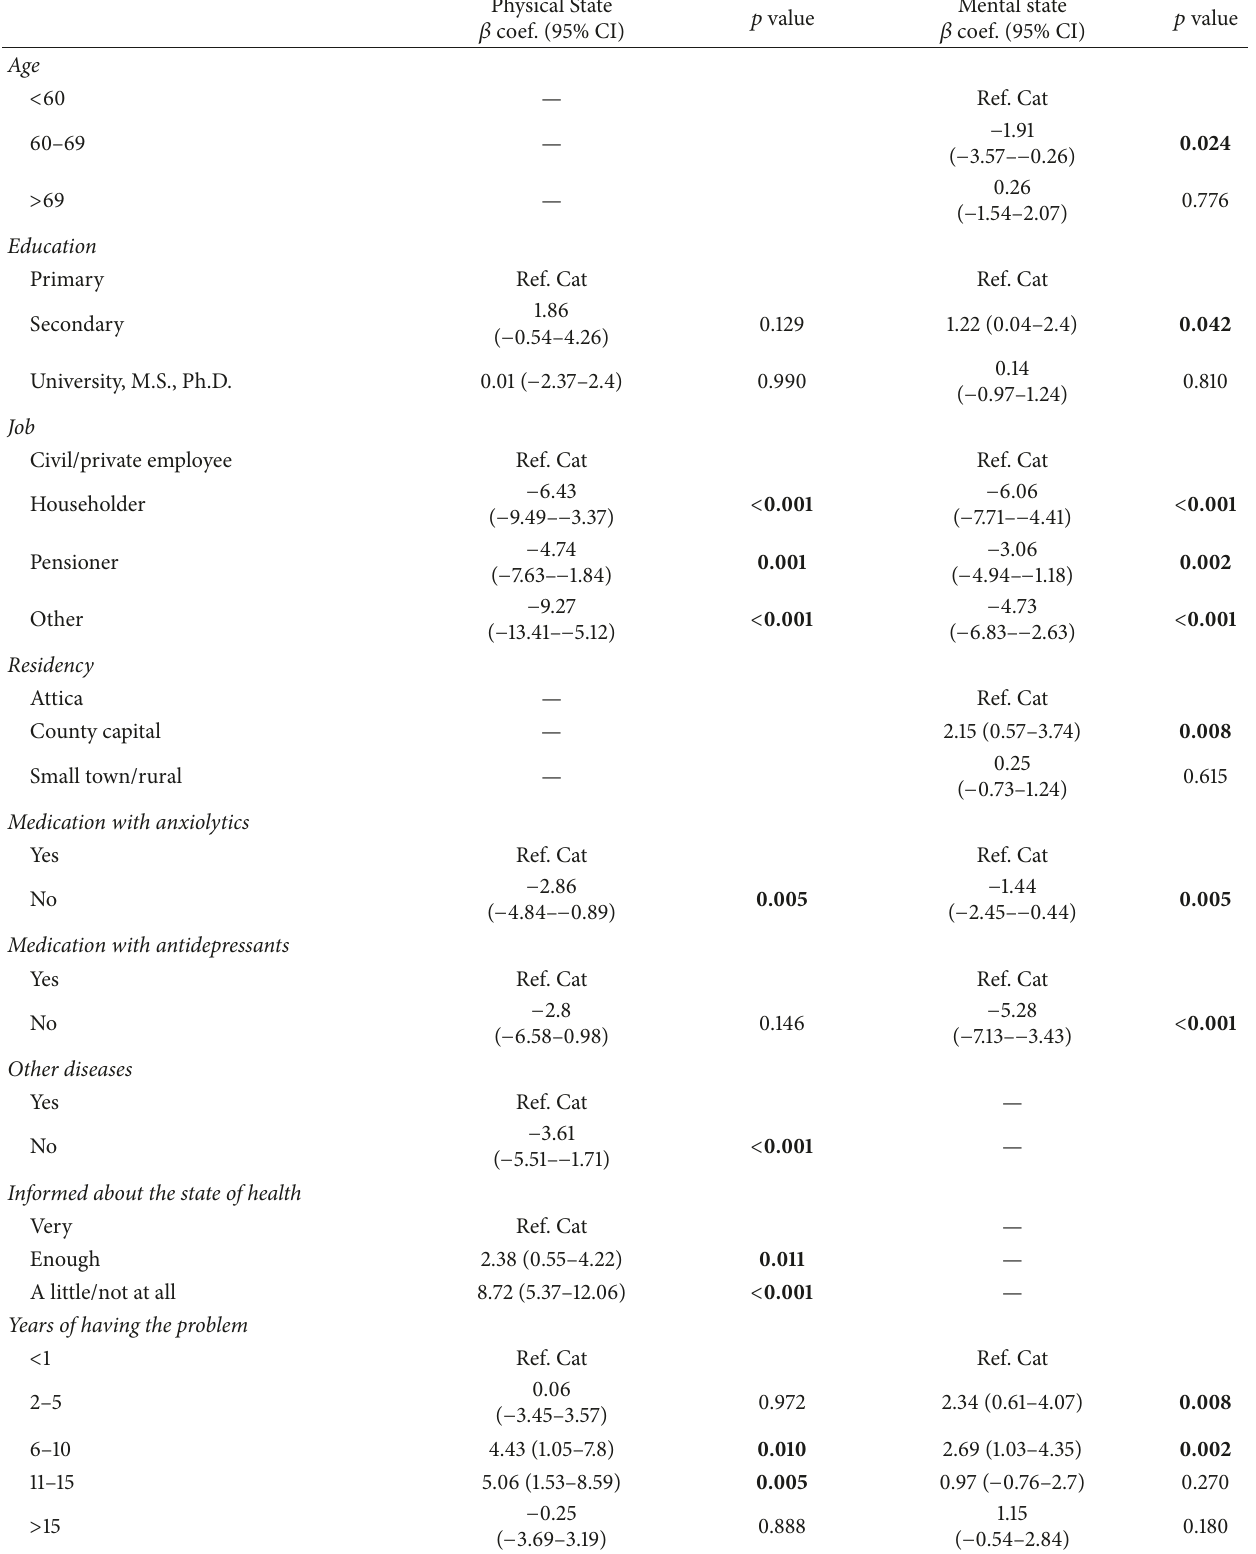
Table 7: Assessment of the effect of the factors on quality of life